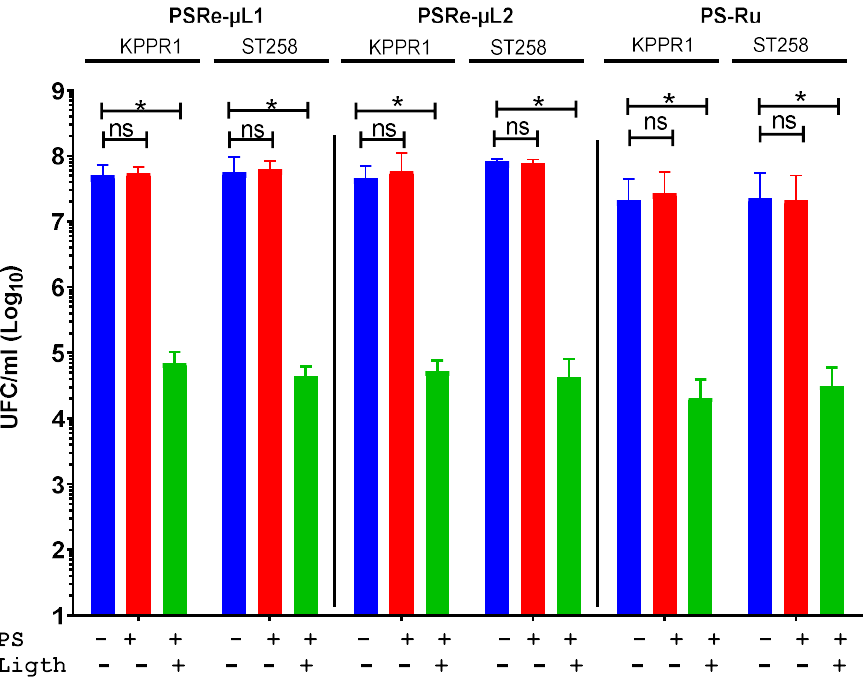
Figure 2. The Photodynamic antimicrobial inhibition of PSRe-µL1 and PSRe-µL2 compounds. The imipenem-sensitive strain (KPPR1) and the imipenem resistant strain (ST258) of K. pneumoniae were used at a 1 × 10 7 CFU/mL and mixed in triplicate with 16 µg/mL of PSRe-µL1, PSRe-µL2, or PS-Ru compounds. The mix was incubated for 1 h at 17 µW/cm 2 with light for aPDI (green bars) or in the dark for controls (red bars). The results were compared to control of bacteria not combined with the PSs (blue bars). Colony count enumerated viable bacteria on ca-MH agar after serial micro-dilution. The CFU/mL values are presented as means ± SD on a log 10 scale. The + and − signs indicate the presence or absence of a compound or condition. Not significant (ns) p > 0.05 by Student’s t -test among bacteria treated with PS without light compared to untreated control bacteria; * p < 0.05 by Student’s t -test among bacteria treated with PS exposed to light compared to untreated control bac- teria.